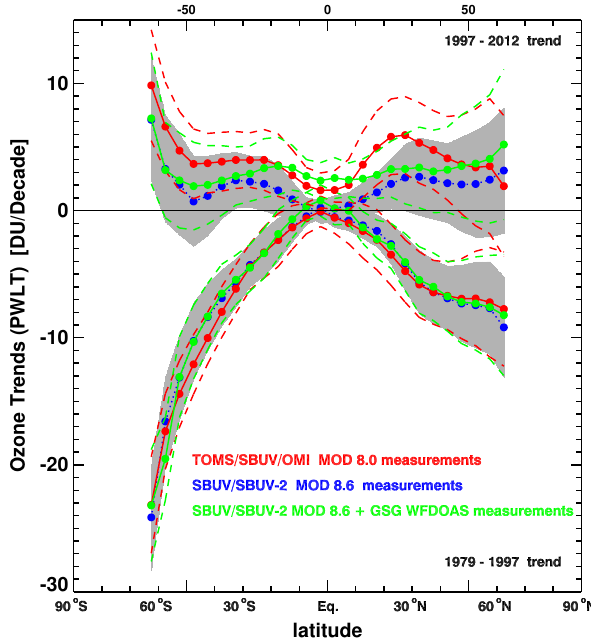
Figure 9. Comparisons between PWLT trends before and after 1997 for the MOD V8.0 (red), MOD V8.6 (blue) and MOD8.6/GSG (green) total ozone data